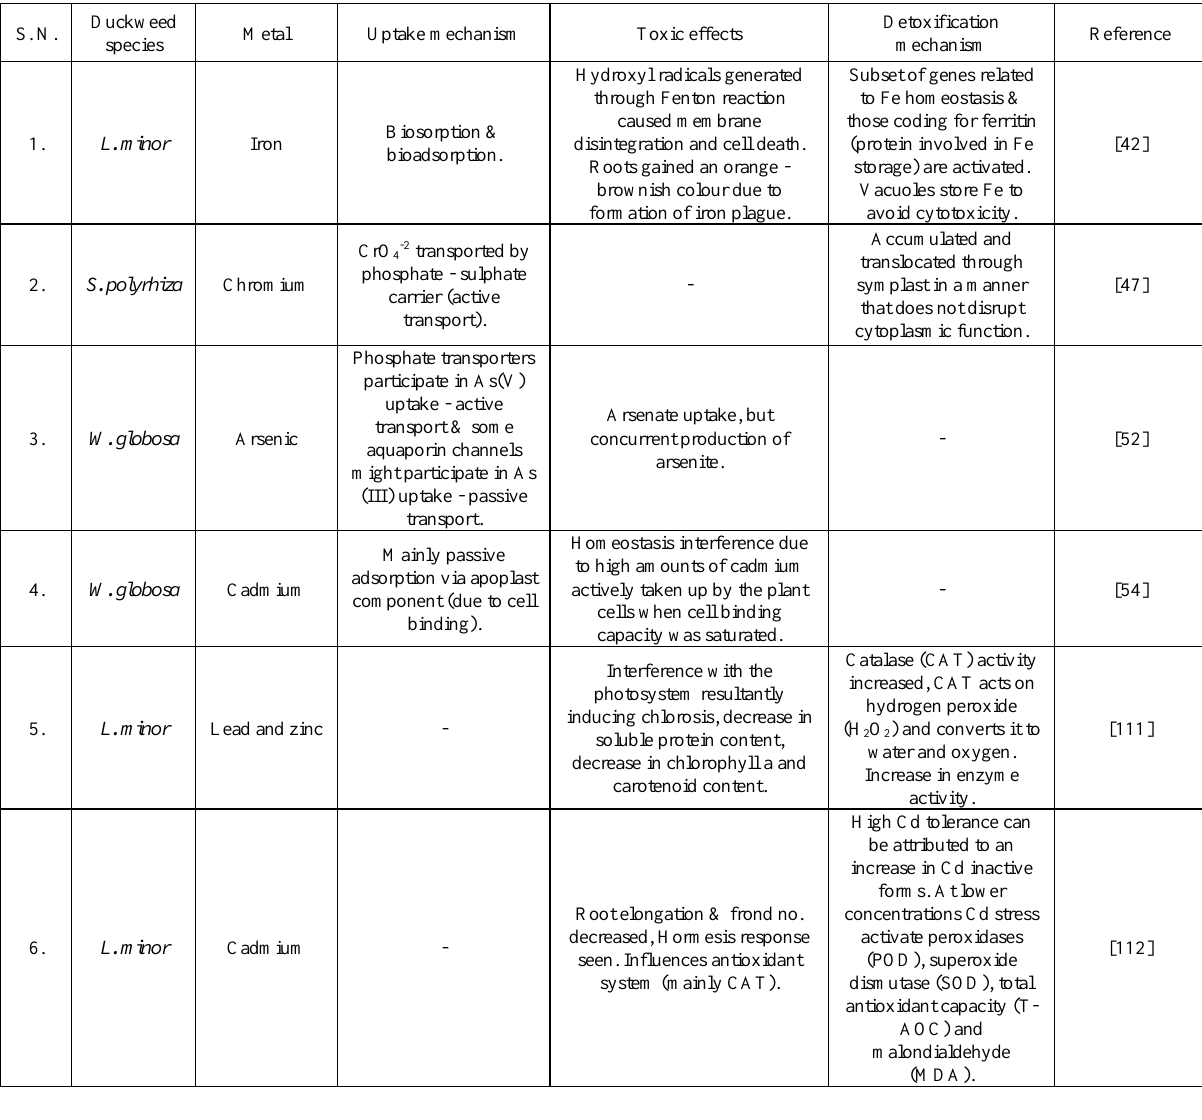
Table 4. Uptake and detoxification mechanism of different duckweed species